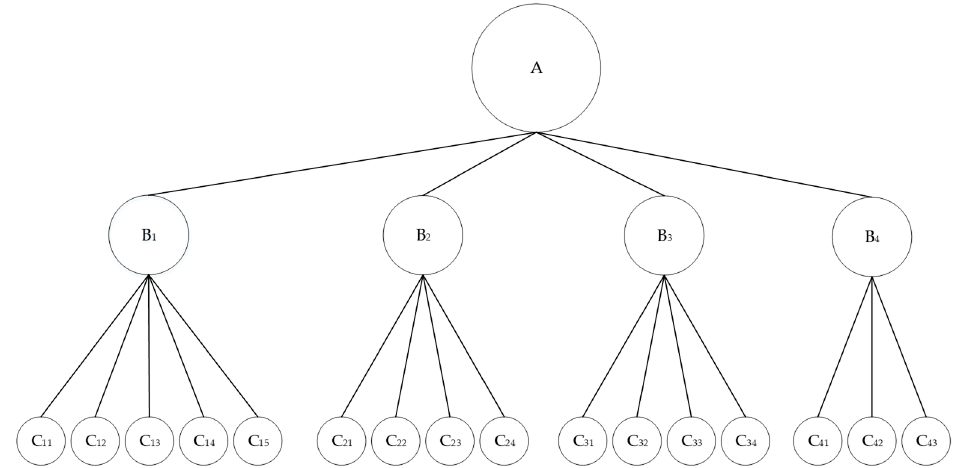
Figure 4. The model of community resilience hierarchy of transient population.